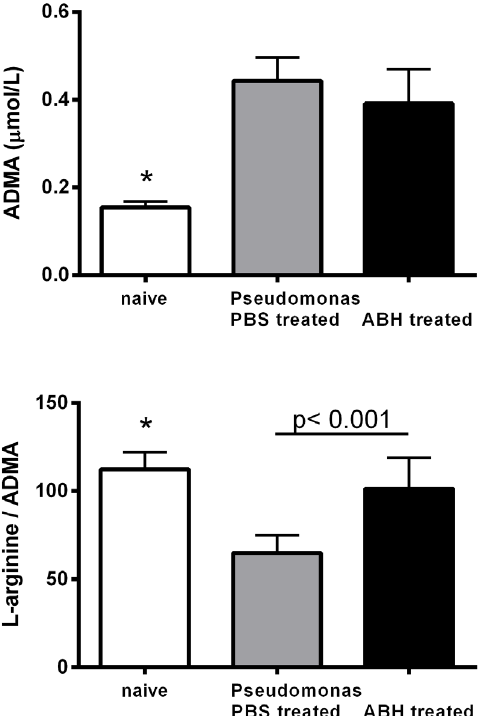
Figure 2. Concentrations of the nitric oxide synthase inhibitor asymmetric dimethylarginine (ADMA) in mouse lung homog- enates of untreated (naı¨ve) control as well as Pseudomonas infected mice treated with PBS or the arginase inhibitor 2(S)-amino-6-boronohexanoic acid (ABH). ADMA was significantly lower in naı¨ve compared to Pseudomonas infected lungs (*: p=0.0001, Kruskal-Wallis test). The L-arginine/ADMA ratio, which can be used as an index of NOS impairment, was significantly reduced in infected lungs (*: p , 0.0001, ANOVA). Treatment with ABH did not change ADMA concentrations but resulted in normalization of the L- arginine/ADMA ratio. (p , 0.001, t-test).